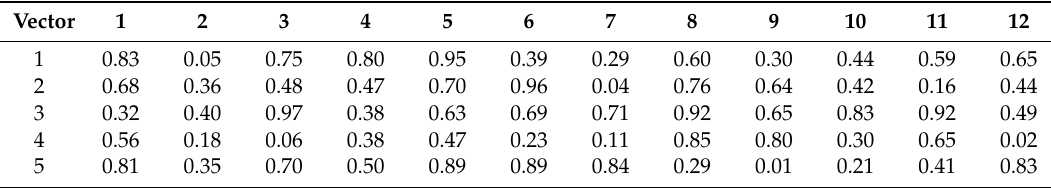
Table 7. Random numbers for the